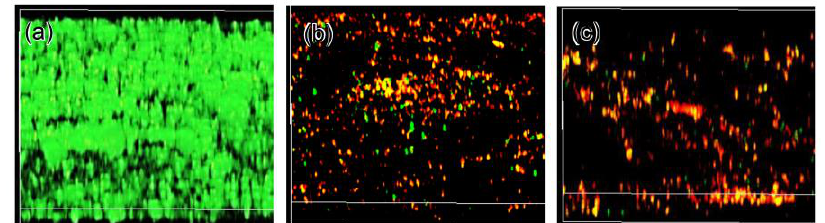
Figure 11. Confocal microscopy of Ti surfaces contacted with multi-resistant Acinetobacter baumannii (MRAB12) for 7 days ( a ) as-polished; ( b ) subjected to NaOH-100Ca + 0.05Ga-heat-water or ( c ) NaOH-100Ga-heat-water treatment. Green: live bacteria, Red: dead bacteria.